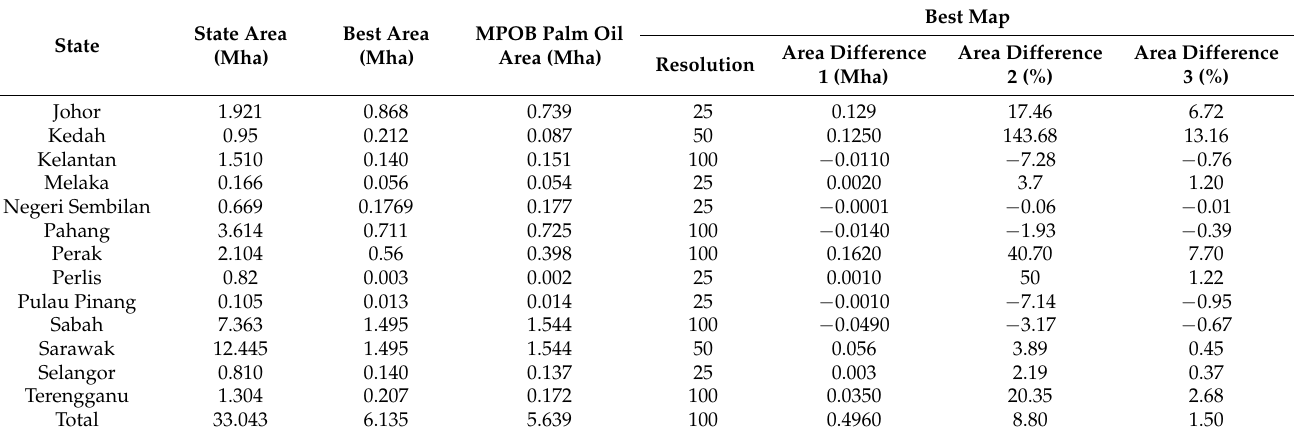
Table 4. Comparison between the best estimated oil palm area from PALSAR-2 and MPOB (Source: